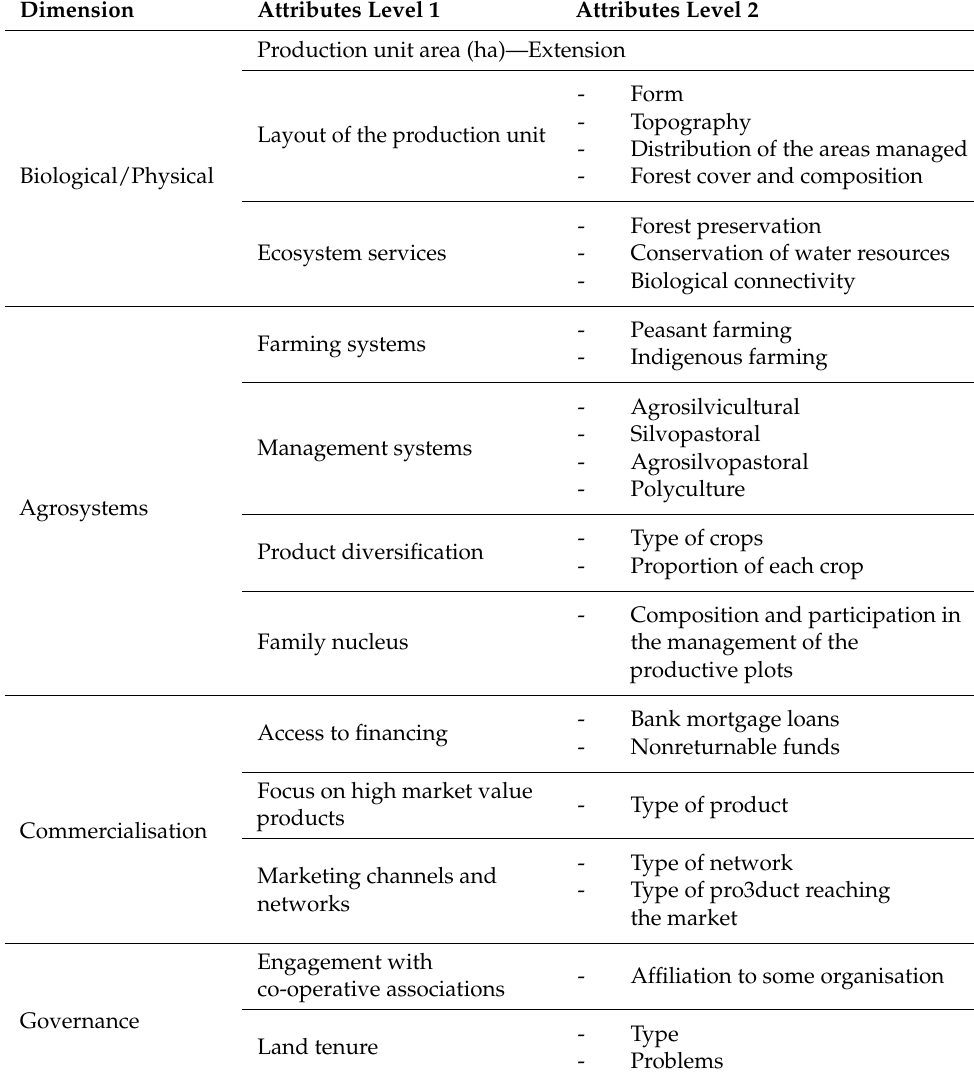
Table 1. Attributes of the productive